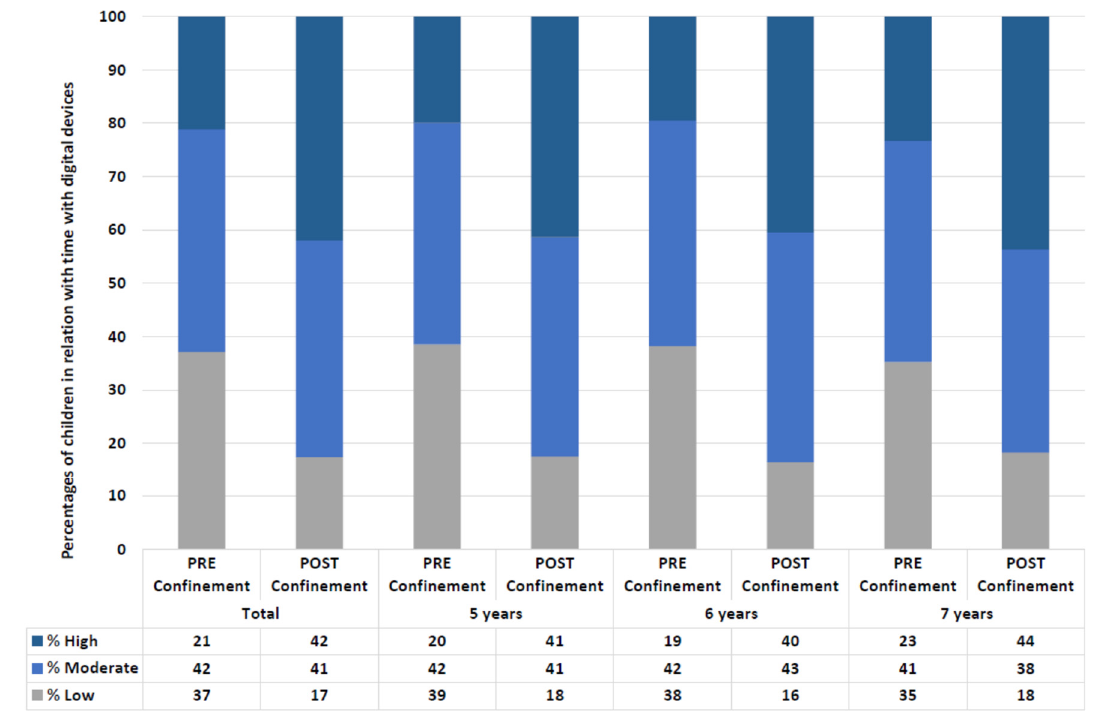
Figure 5. Classification of children depending on the percentage of screen-time while doing near distance activities in all the sample and by ages (Low: <25% of the time doing near activities with digital devices; Moderate: 25–50% of the time doing near activities with digital devices; High: >50% of the time doing near activities with digital devices).